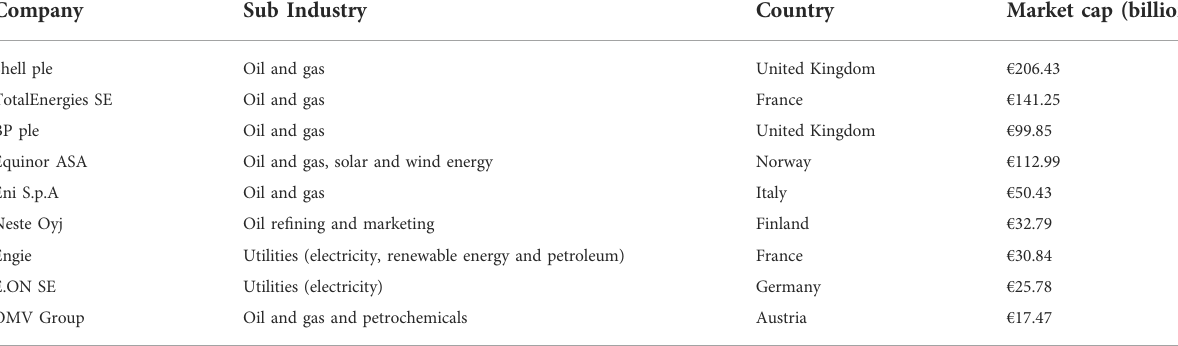
TABLE 5 Summary of the sample used in this research. Source: Bloomberg, 2022.